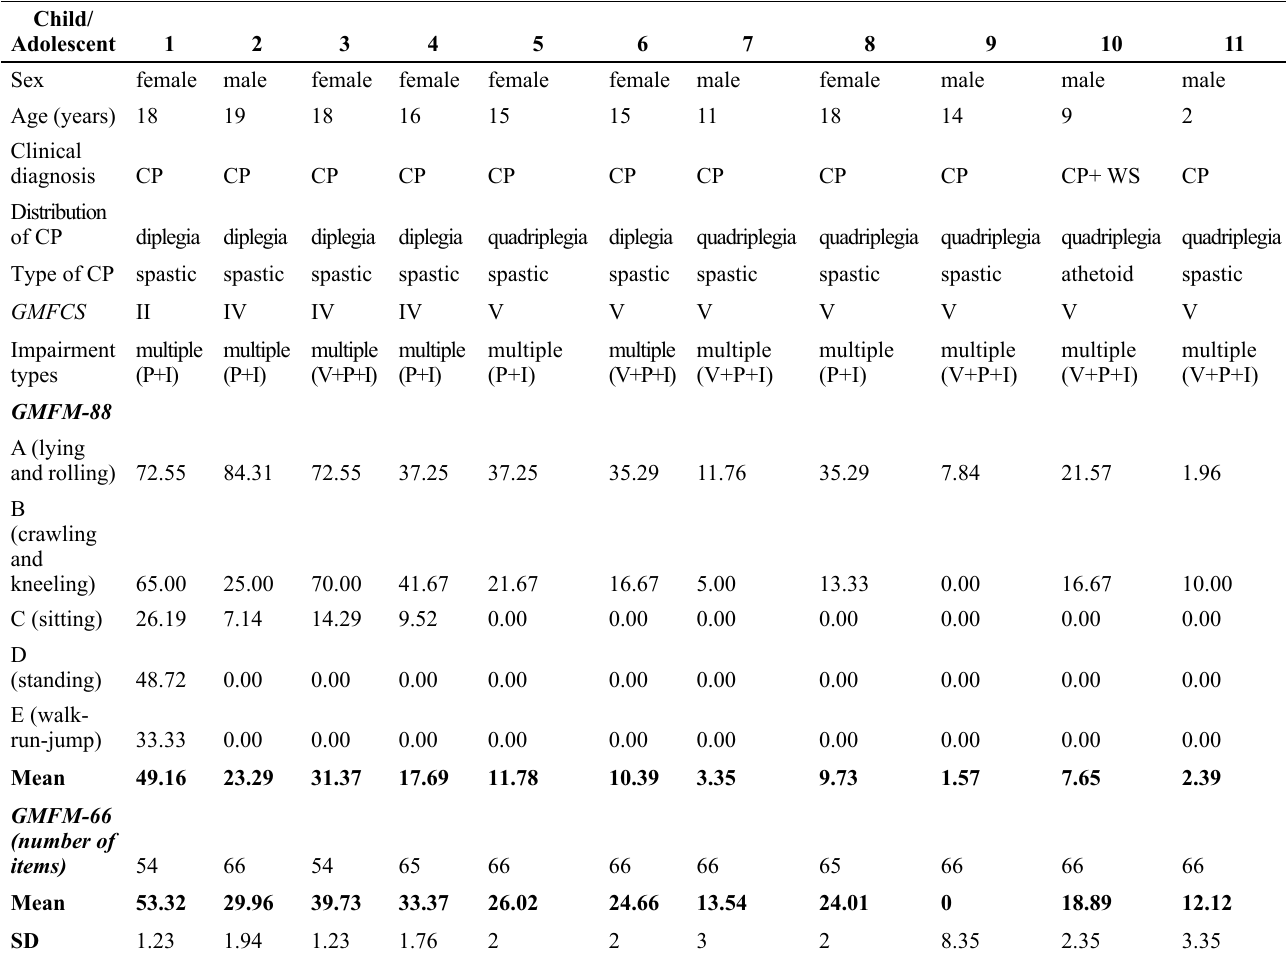
Table 1. Results of the evaluation of children and adolescents with CP